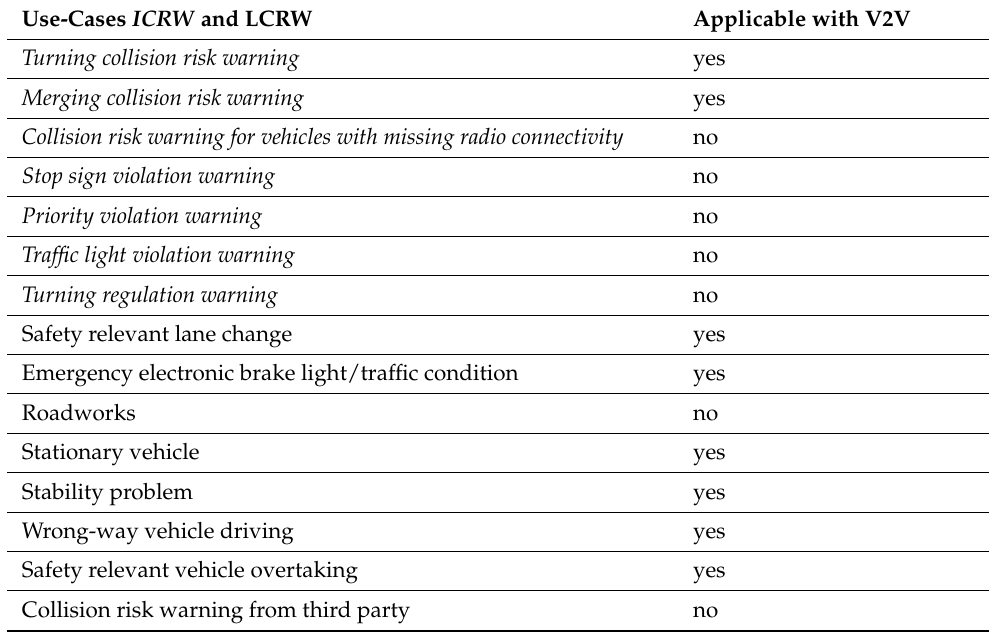
Table 4. Applicability of all use-cases of ICRW and LCRW according to [6,7] using vehicle-to-vehicle communication only.